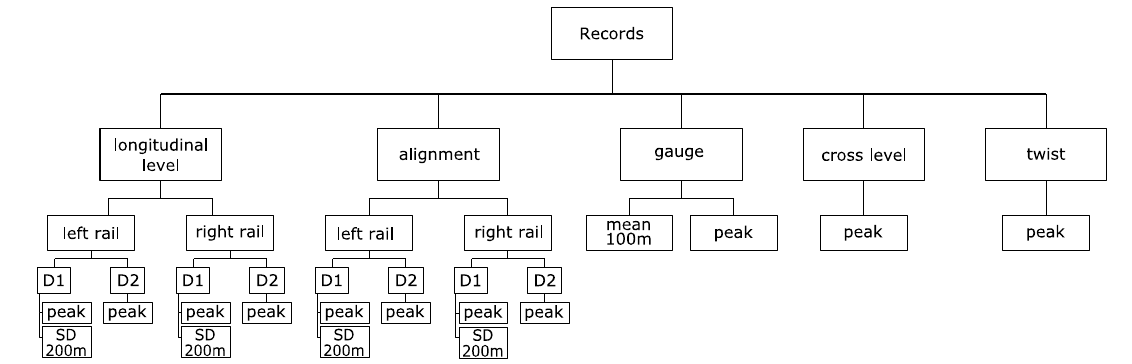
Figure 3. Geometrical track quality assessment.